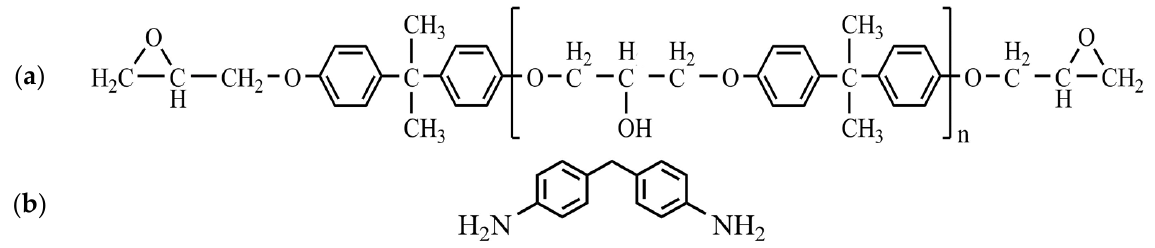
Figure 1. Structural formulae: ( a ) ED-20 epoxy oligomer and ( b ) 4,4’-diaminodiphenylmethane. Two different types of TiO 2 nanopowders obtained by the plasma-chemical method [48] have the following characteristics: (1) d av = 46 nm, specific surface area (SSA) = 42.5 m 2 /g, ρ = 4.2495 g/cm 3 , and phase composition is anatase—75% and rutile—25%; and (2) d av = 100 nm, SSA = 13.3 m 2 /g, ρ = 4.2700 g/cm 3 , and phase composition is anatase—60% and rutile—40%.